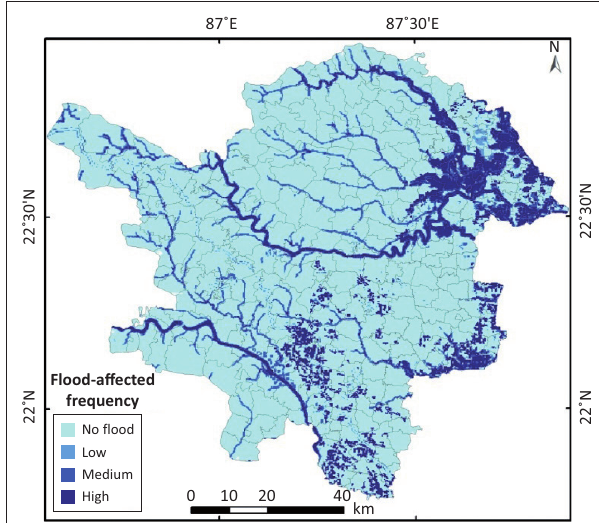
FIGURE 6: Flood affected frequency map.